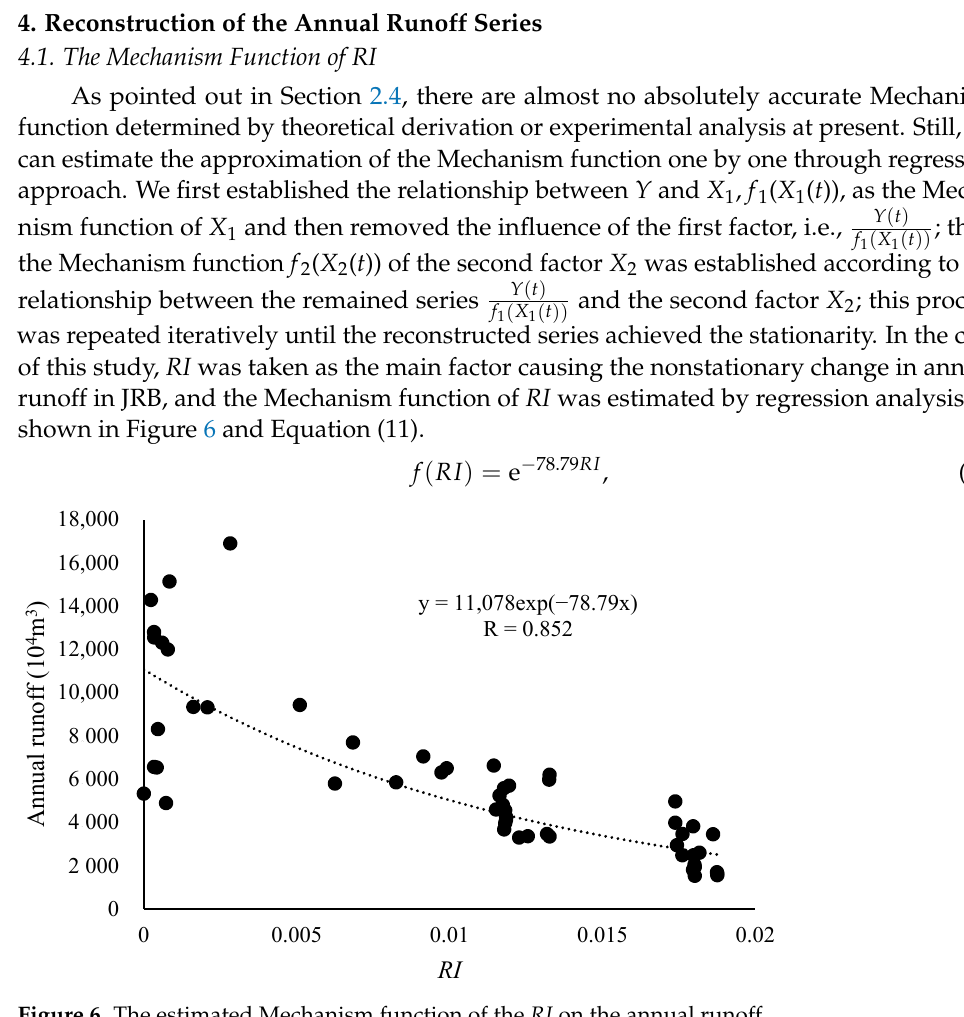
Figure 6. The estimated Mechanism function of the RI on the annual runoff.